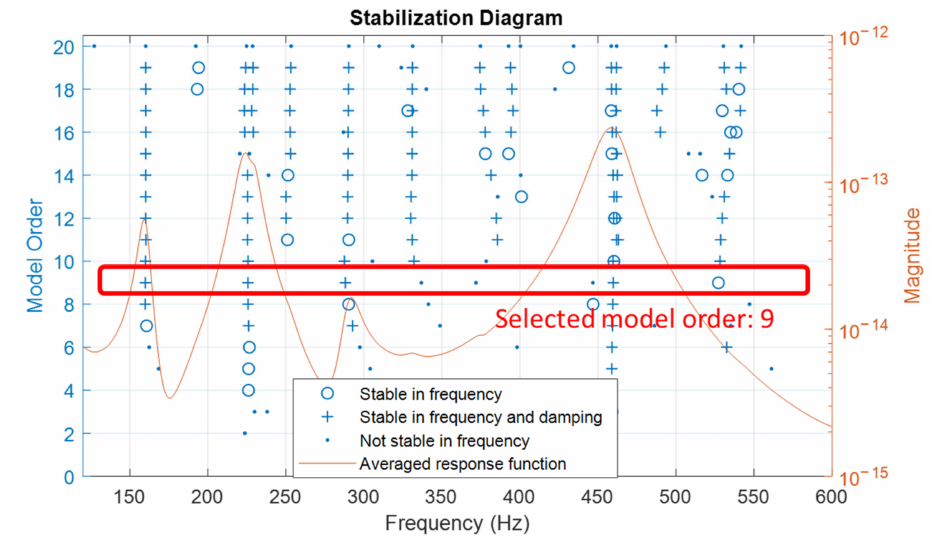
Figure 4. The stabilization diagram obtained with the measured FRFs.